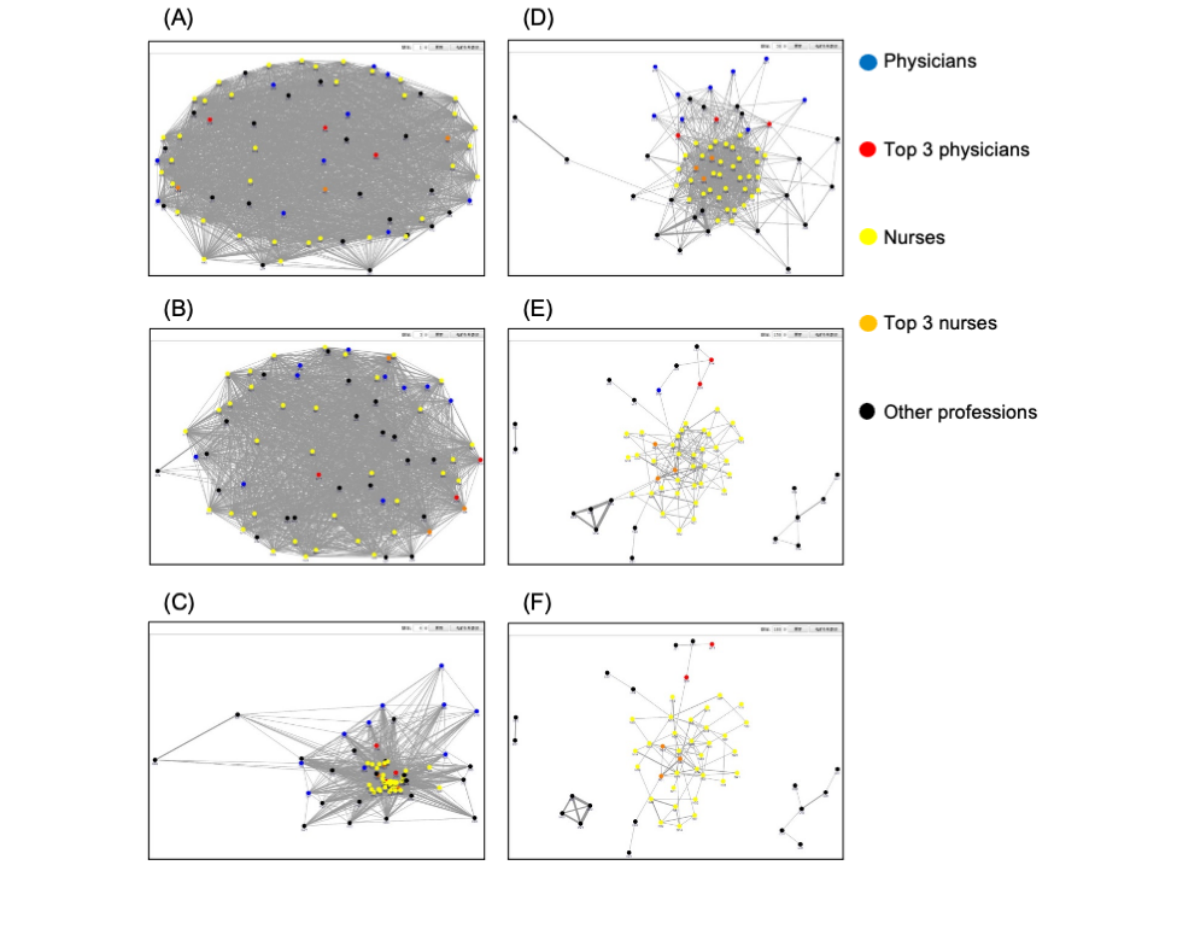
Figure 2. Social network analysis of active face-to-face interactions. Nodes represent individual ICU staff: blue and red, doctors; yellow and orange, nurses; black, other professions. The top 3 doctors and nurses who actively interacted the most are denoted by red and orange nodes, respectively. The following threshold values were used to define those links connecting the nodes: (A) 1, (B) 3, (C) 4, (D) 30, (E) 150, and (F) 180 minutes during the 4-week measurement